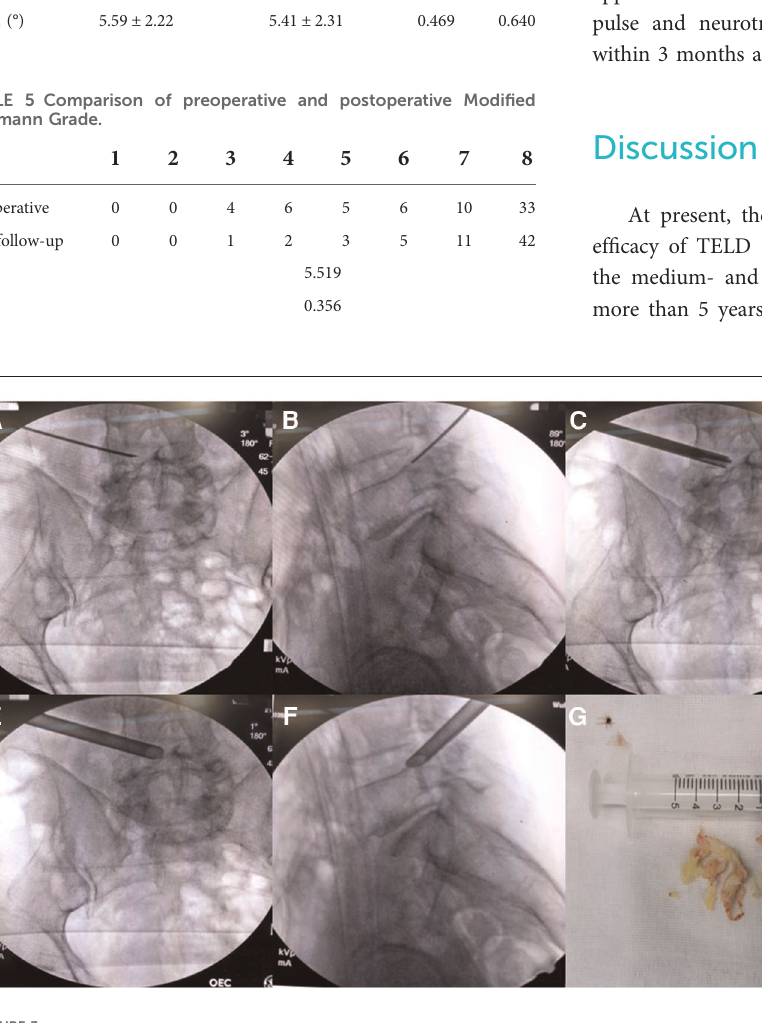
FIGURE 3 ( A,B ) anteroposterior and lateral position x-ray radiographs indicate the location of the spinal needle; ( C,D ) anteroposterior and lateral position x-ray radiographs indicate the location of the serrated reamer, which was used for zygapophyseal plasty; (E,F ) anteroposterior and lateral position x-ray radiographs indicate the location of the working channel; ( G ) extracted the prolapse of nucleus pulposus; ( H ) suf fi cient decompression of the nerve root was seen under the